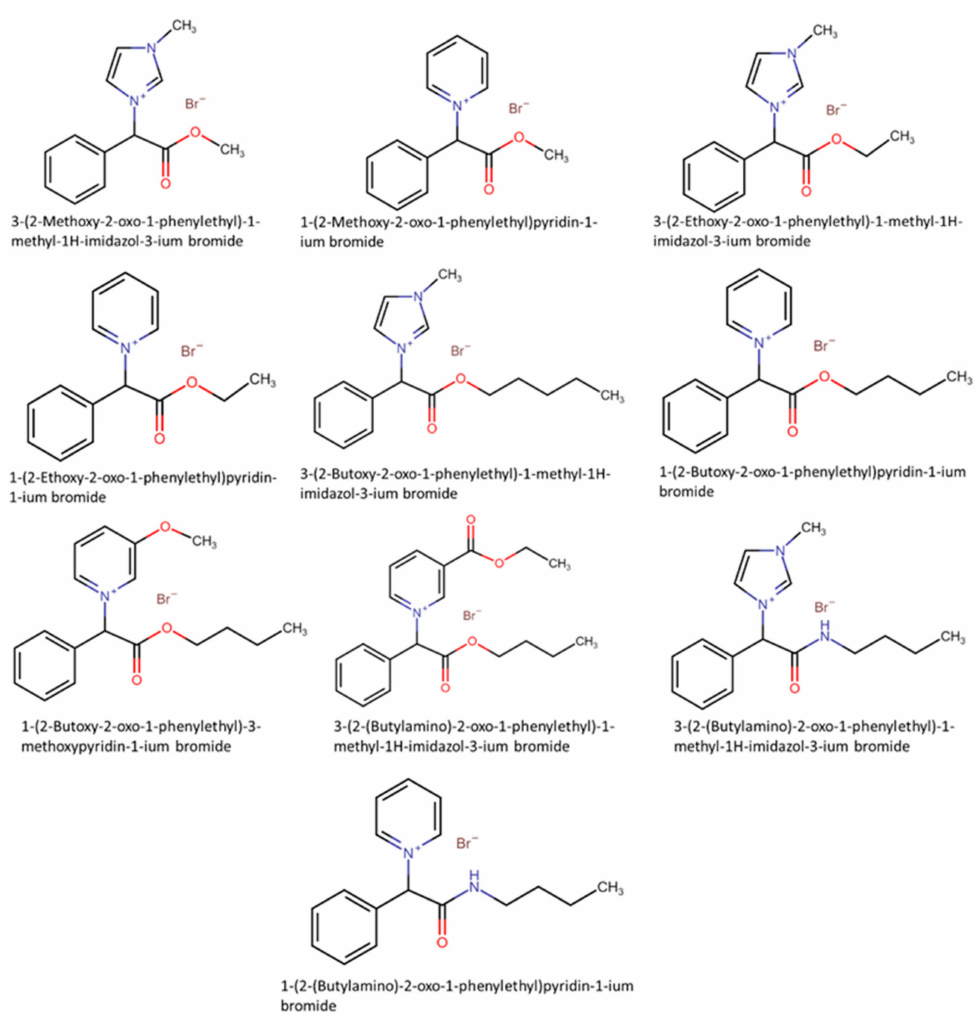
Figure 5. Structures of alkyl[(1R,2S,5R)-( − )-menthoxymethyl] dimethylammonium chloride [66]. Thamke and coworkers [67] presented the toxicity of five ILs: 1-butyl-3-methylimidazolium bromide ([C 4 mim][Br]), trihexyltetradecylphosphonium dicyanamide ([P 6,6,6,14 ][N(CN) 2 ]), 1-decyl-3-methyl imidazolium tetrafluoroborate ([C 10 mim][BF 4 ]), benzyldimethyltetradecy- lammonium chloride ([BTDA][Cl]) and 1-butyl-4-methylpyridinium chloride ([C 4 mpy][Cl]) against bacteria (Gram-positive: Bacillus subtilis , S. aureus ; Gram-negative: E. coli , P. aerugi- nosa , Bradyrhizobium japonicum ( B. japonicum ), Thiobacillus novellus ( T. novellus ), and Alcali- genes faecalis ( A. faecalis ), these last three are abundant in agricultural soil), fungi ( C. Albicans and Aspergillus brasiliensis (A. brasiliensis) ), plants ( Triticum aestivum seeds and onion